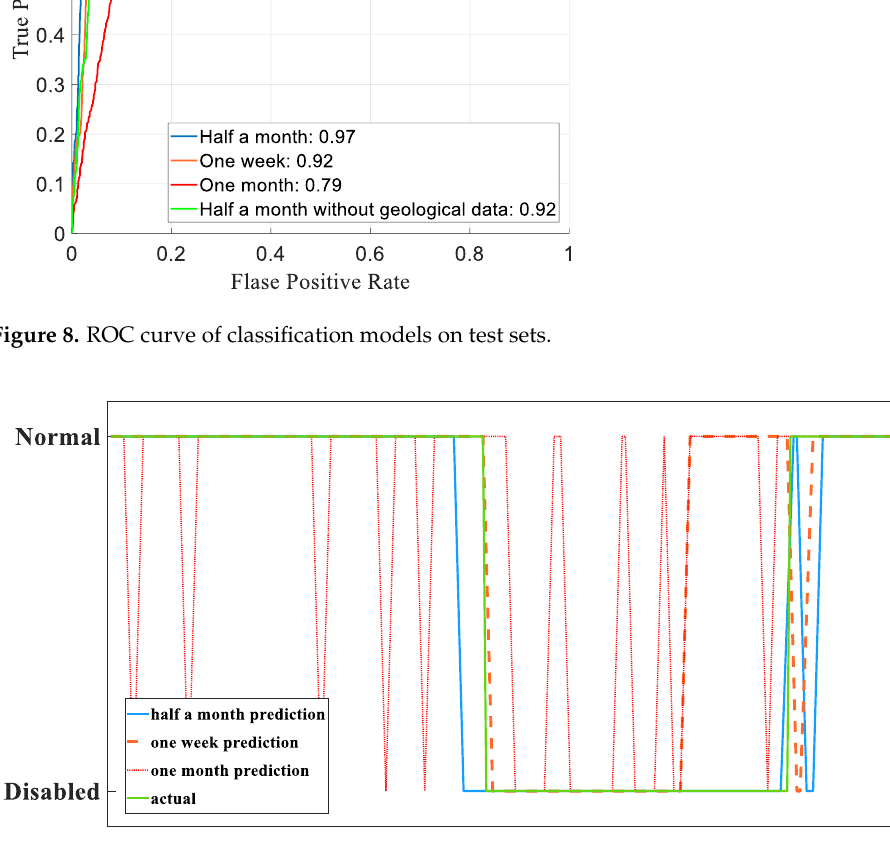
Figure 9. Comparison of predicted and actual conditions of TBM disc cutters from 6 to 12 June 2016.